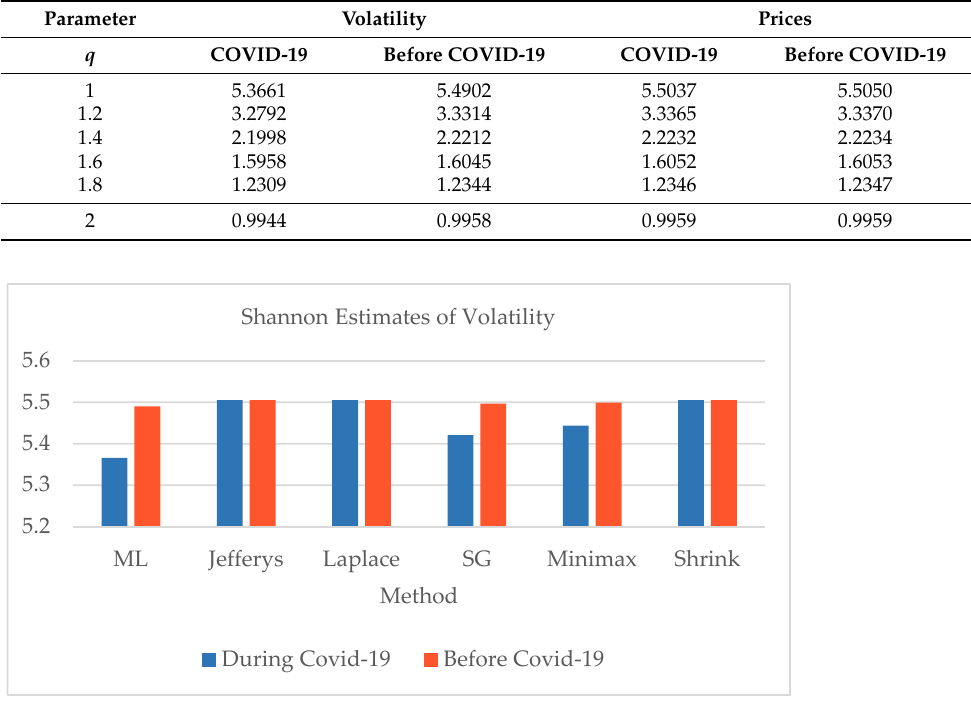
Figure 3. The plot of Shannon entropy estimates for estimated volatility series of PSX-100. Table 5. Estimates of Tsallis entropy for PSX-100 estimated volatilities and closing prices.